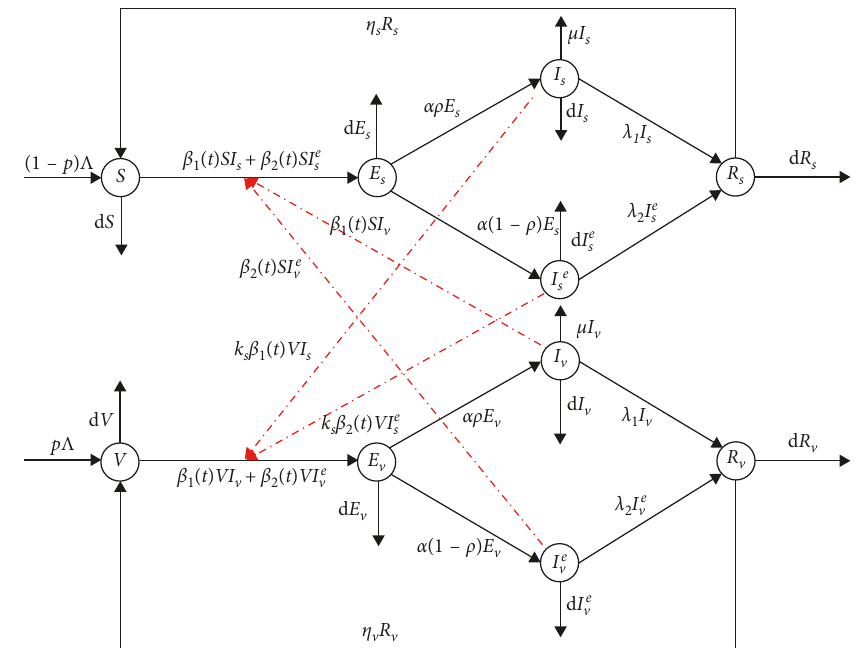
Figure 2: Flow diagram representing transmission routes and other processes modeled by system